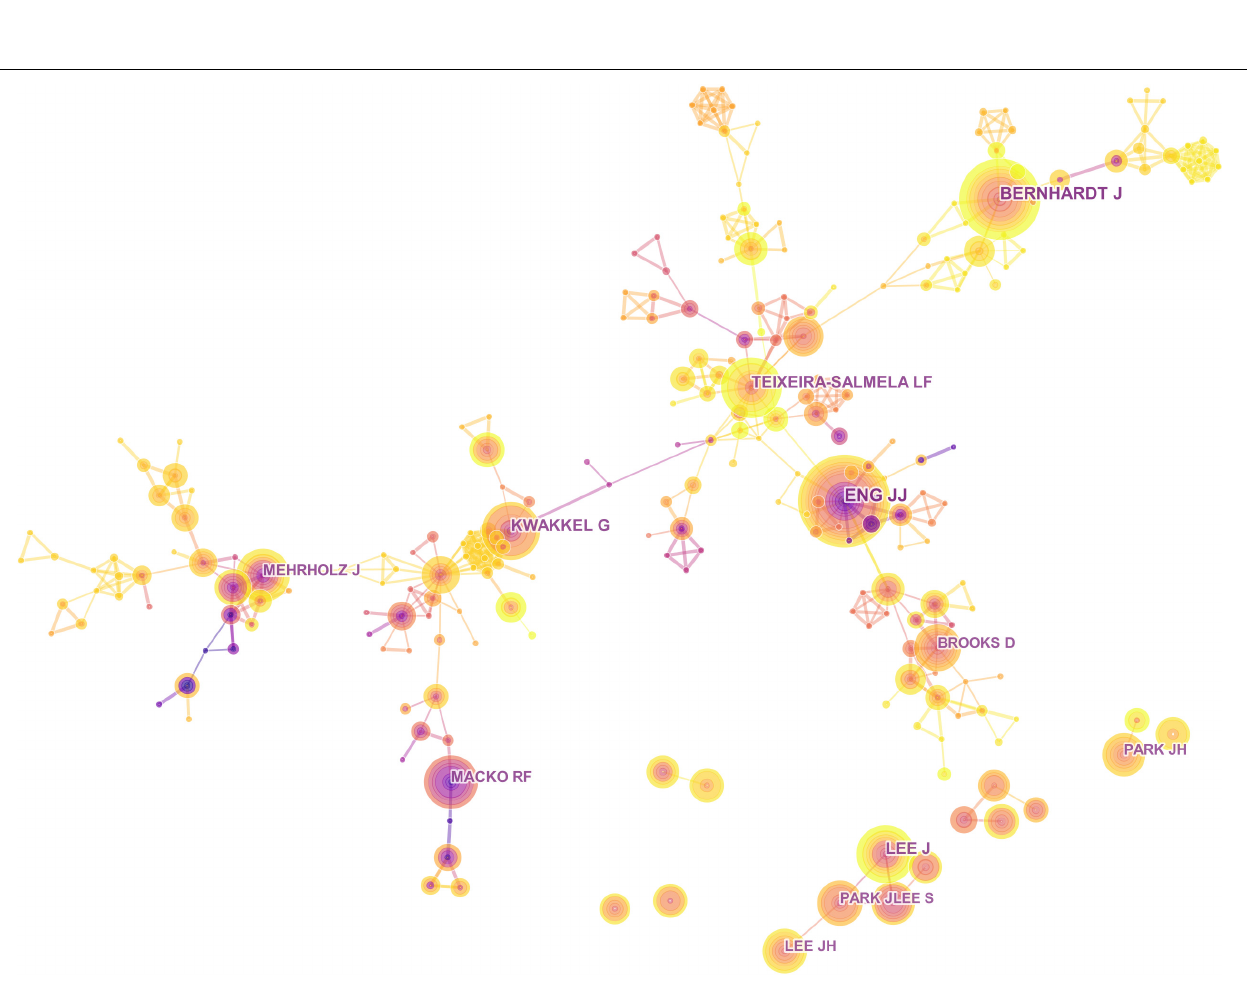
FIGURE 4 | The dual-map overlay of journals.